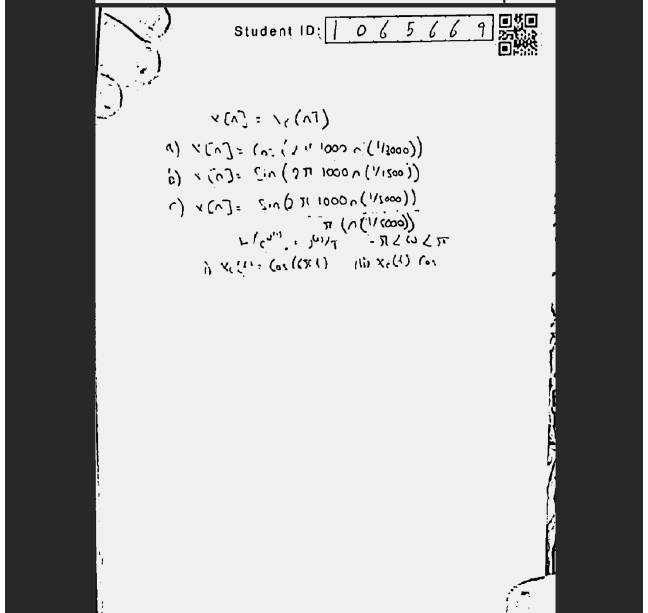
Figure 20. A sample of the pages scanned by the image scanning system.